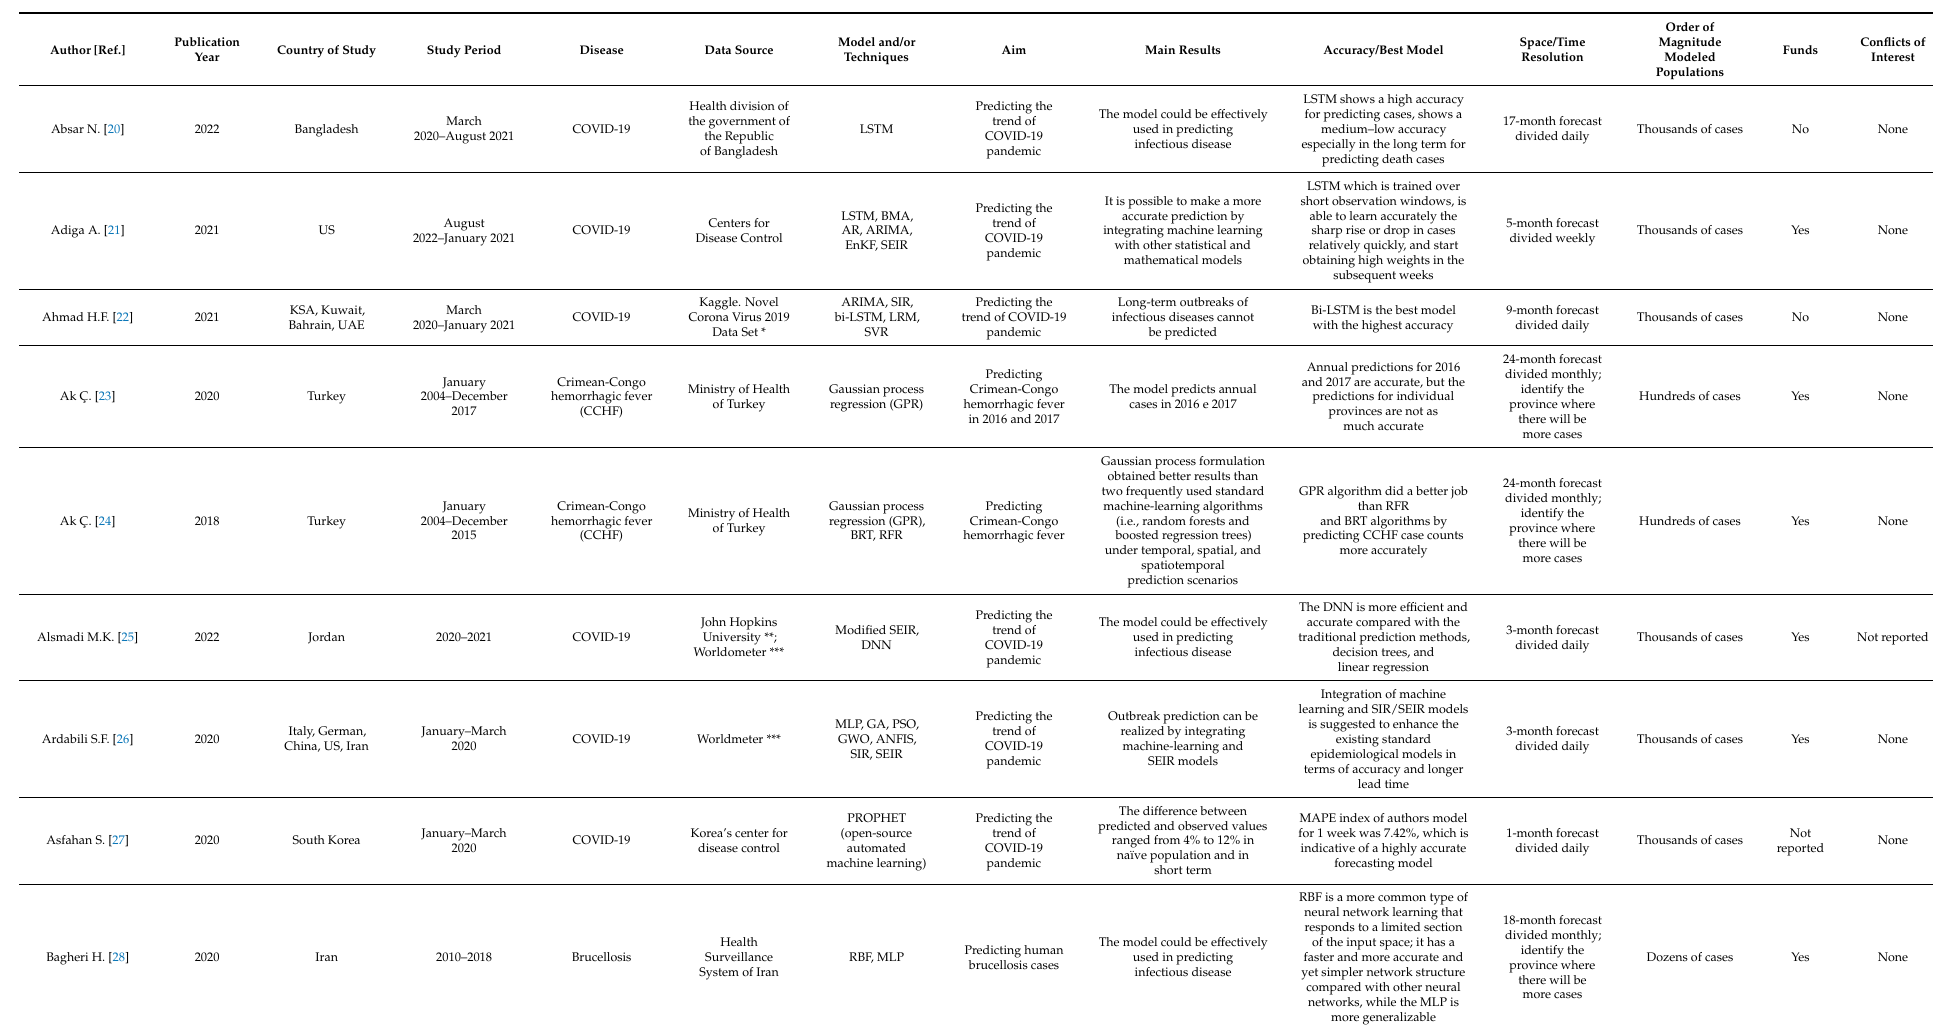
Table 1. Qualitative characteristics of included studies, reported in alphabetical order. From the study of Ajith A [74] the proceedings/conference